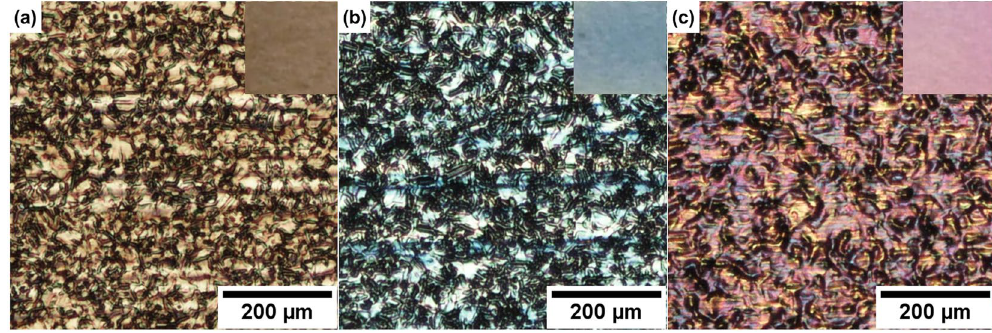
Figure 1. Optical microscopy images of the colorized surface. ( a ) Sample 1, straw-yellow, ( b ) Sample 2, cornflower-blue, ( c ) Sample 3, fuchsia. Photos of insets were taken by digital camera.